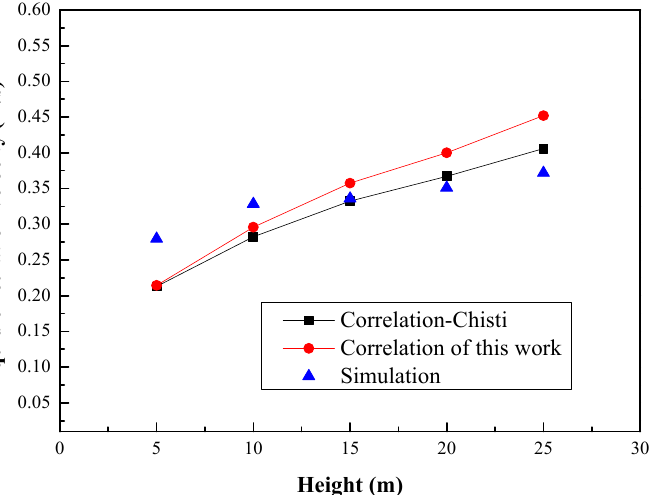
Figure 13. Comparison of liquid circulation velocity calculated from the correlations and CFD simulation at different total column heights.